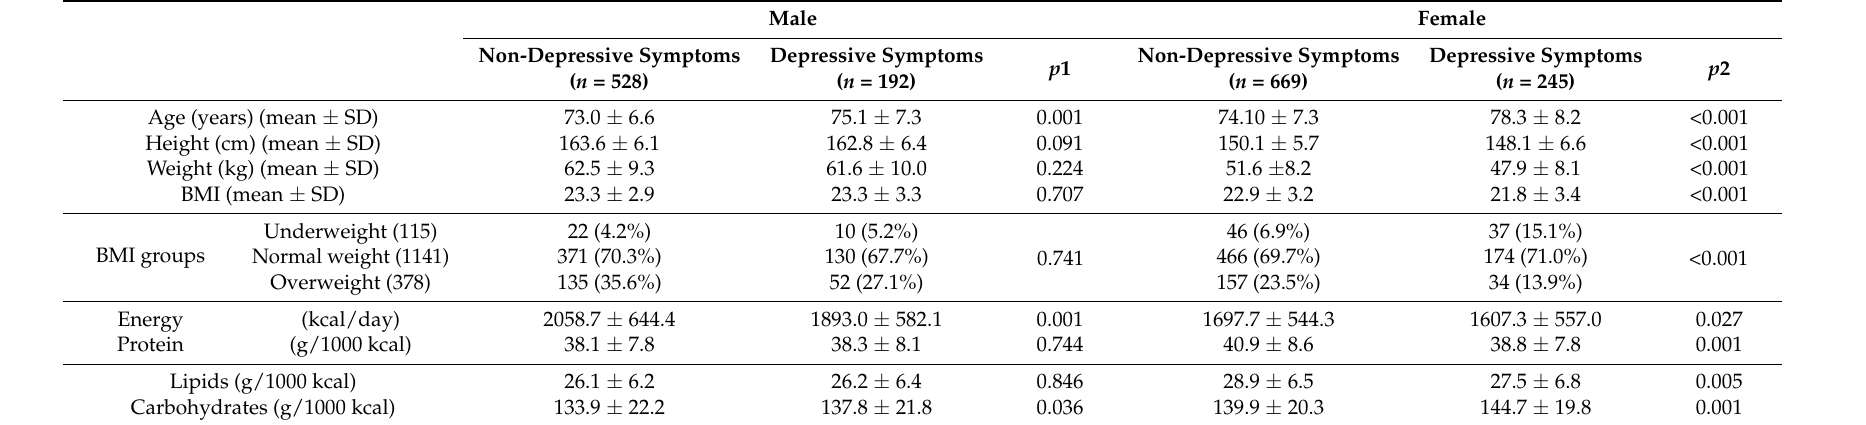
Table 1. Participant